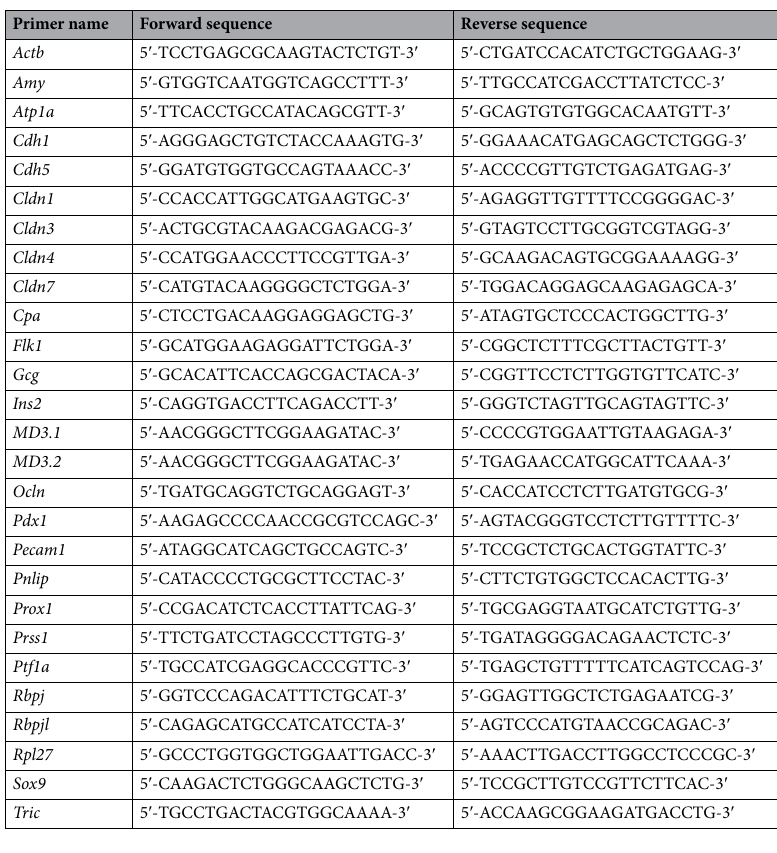
Table 2. RT-qPCR